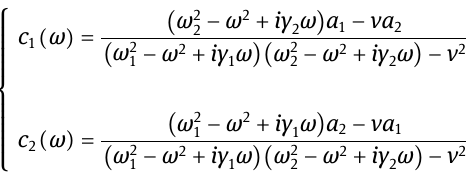
λ = 815 nm. (d) Calculatedoutput spectra fordifferent x